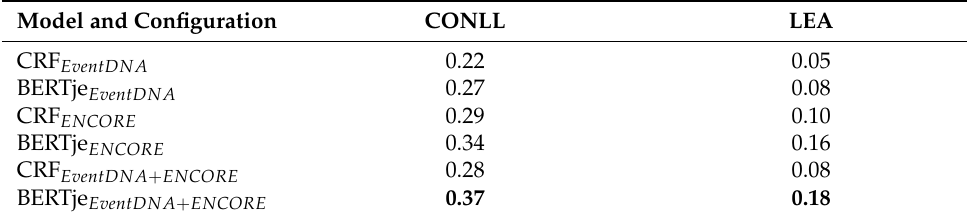
Table 6. Overview of training the models with different data configurations.